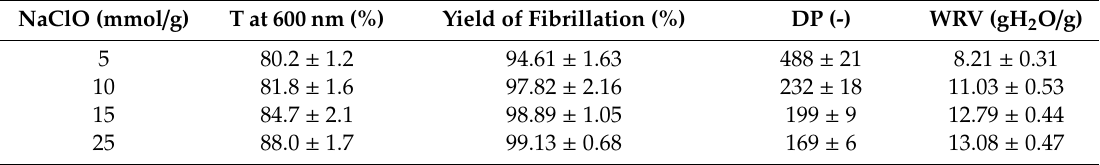
Table 1. Characterization of CNF obtained with di ff erent oxidizer amounts (NaClO). NaClO (mmol / g) T at 600 nm (%) Yield of Fibrillation (%) DP (-) WRV (gH 2 O /